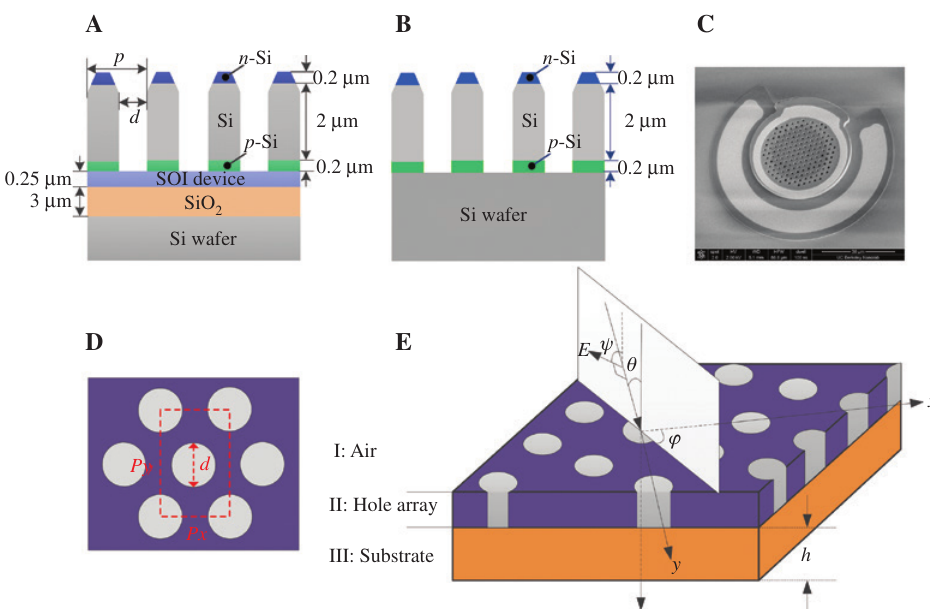
Figure 1: Design of photodiodes with integrated photon-trapping holes on both SOI and bulk Si wafers. (A and B) The n - i - p photodiode structure on an SOI wafer (A) and a bulk Si wafer (B), showing the integrated funnel-shaped holes that span the n , i , and p layers. (C) Scanning electron micrograph of the active region of an Si PIN photodiode (30 μ m diameter). (D) Holes in hexagonal lattice. (E) Periodic hole array illuminated by a plane wave with a rectangular Cartesian coordinate system added for